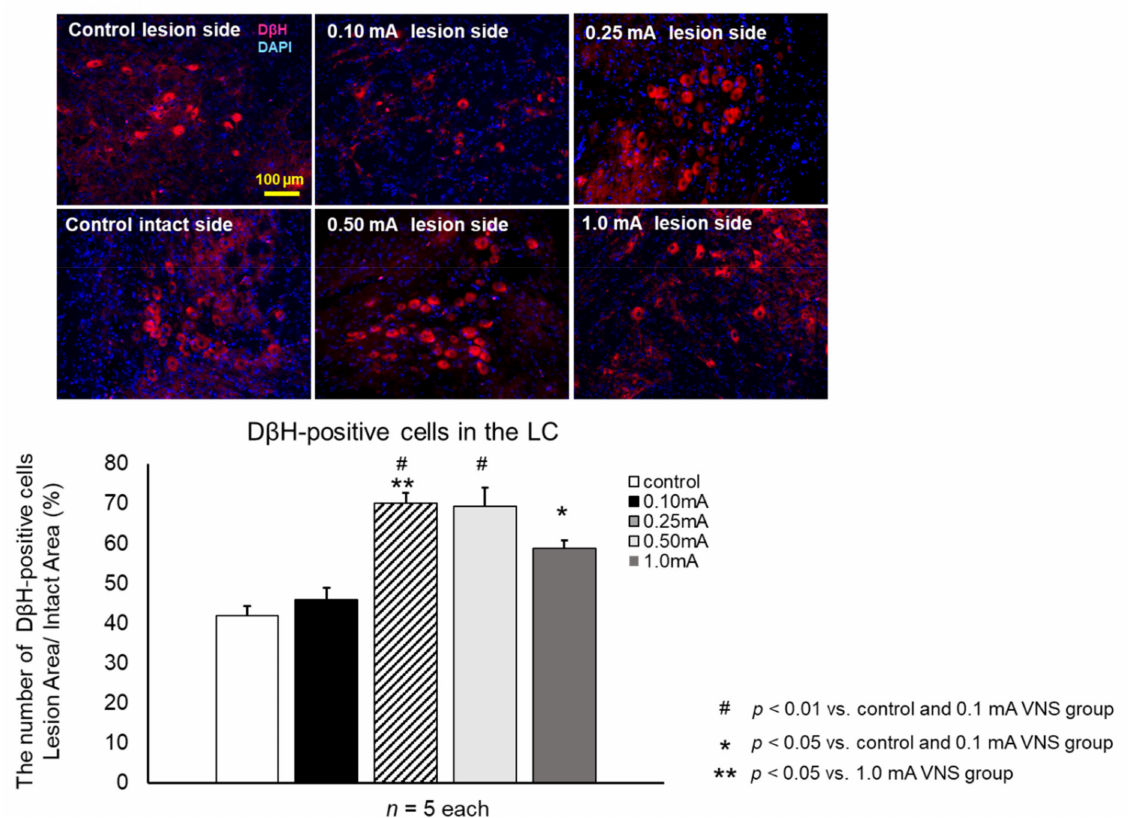
Figure 9. VNS with mild to moderate stimulation intensity preserved noradrenergic neuron in the LC. The ratio of dopamine β hydroxylase (D β H)-positive noradrenergic neurons in the lesioned LC to the intact side was significantly increased in the 0.25 mA, 0.5 mA, and 1 mA VNS groups compared to the control and 0.1 mA VNS groups ( ## p < 0.01 in 0.25 mA VNS group, # p < 0.01 in 0.5 mA VNS group, ** p < 0.05 in 1 mA VNS group). In addition, the preservation effect of the 0.25 mA VNS group was significantly superior to that of the 1 mA VNS group (* p < 0.05). The data are presented as means ± SE and analyzed by one-way ANOVA and Turkey’s post hoc tests. n = 5